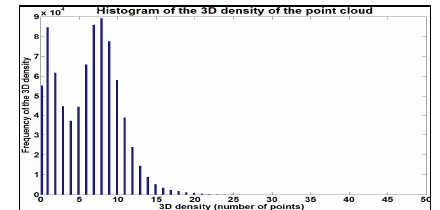
Figure 6. 3D density of Auriga Dr data.